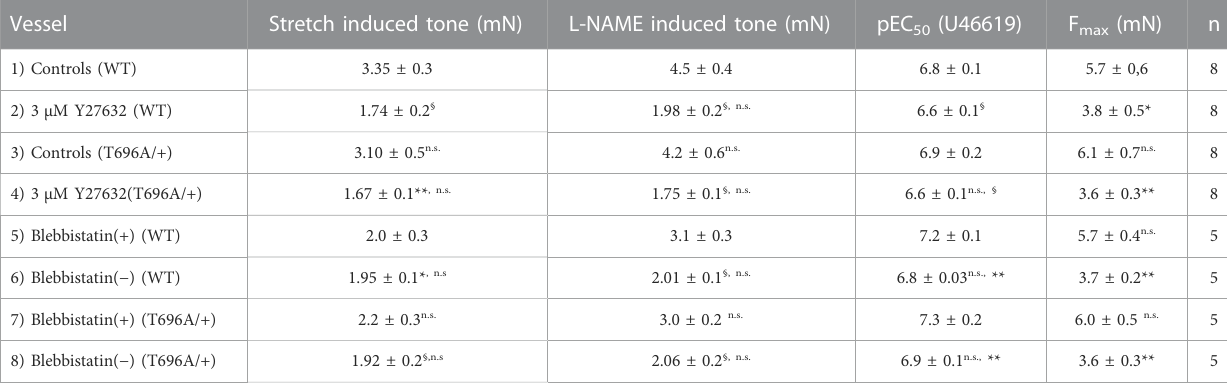
TABLE 3 Contractile parameters of intact preparations from senescent basilar arteries from wild type (WT) and heterozygous (MYPT1-T696A/+) mice. Vessel Stretch induced tone (mN)